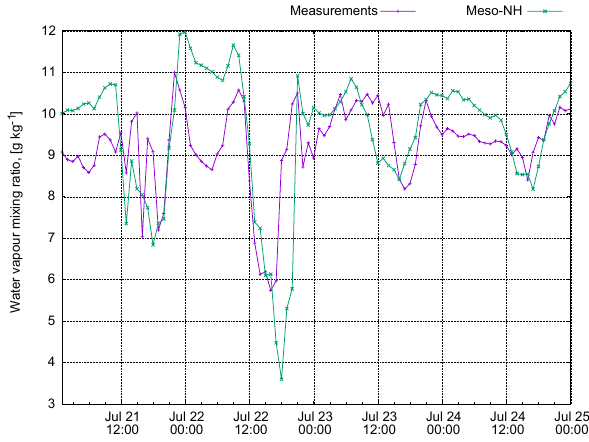
Figure 13. Observed and simulated water vapour mixing ratio at the Montante